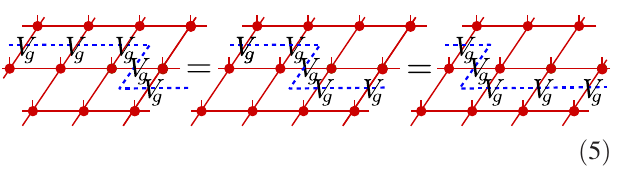
[Eq. (4)], g form electric g